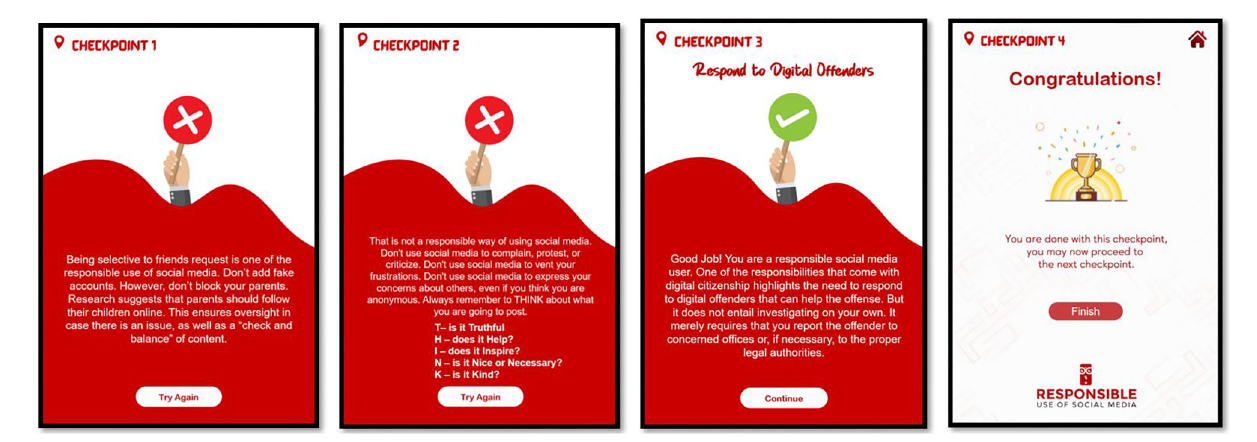
FIGURE 7 | The interface of a wrong and correct choice with the